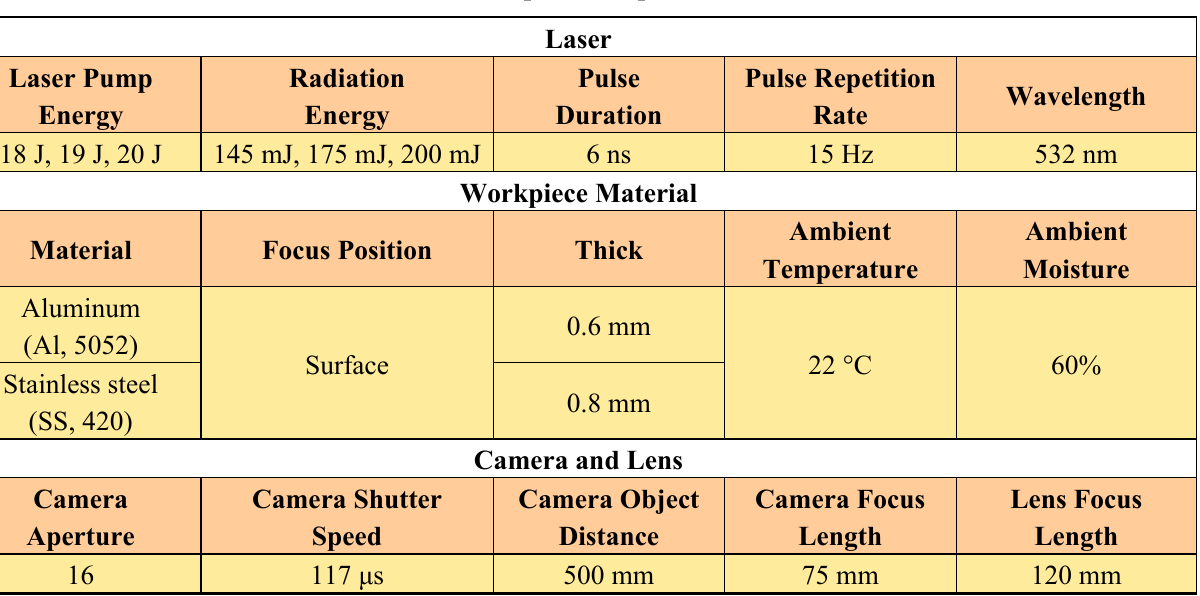
Table 1. Experiment parameters.